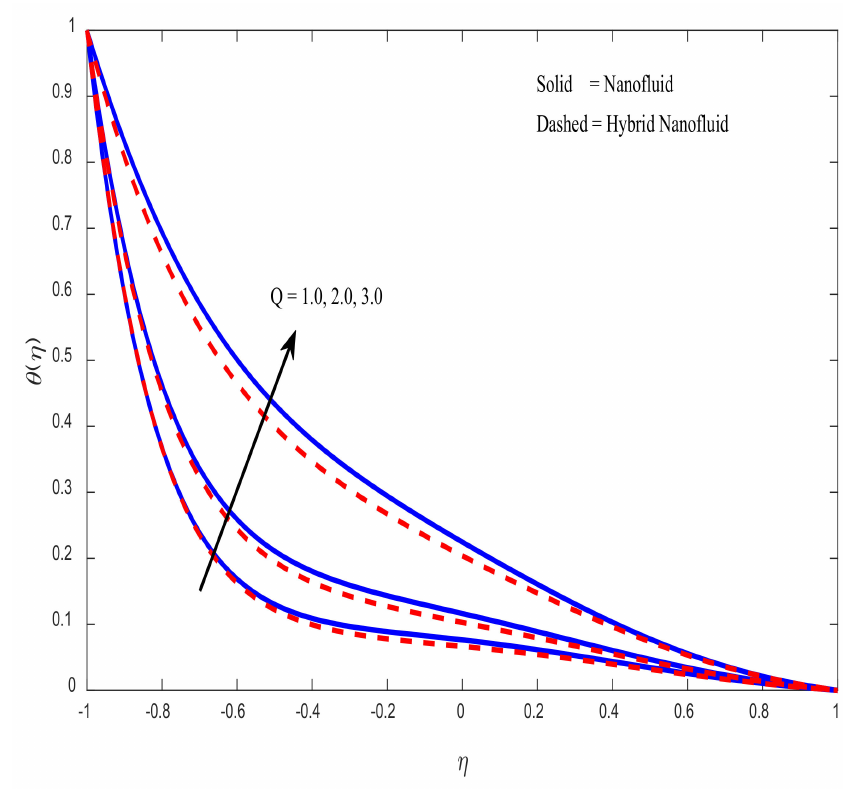
Figure 8. Influence of Q on the temperature